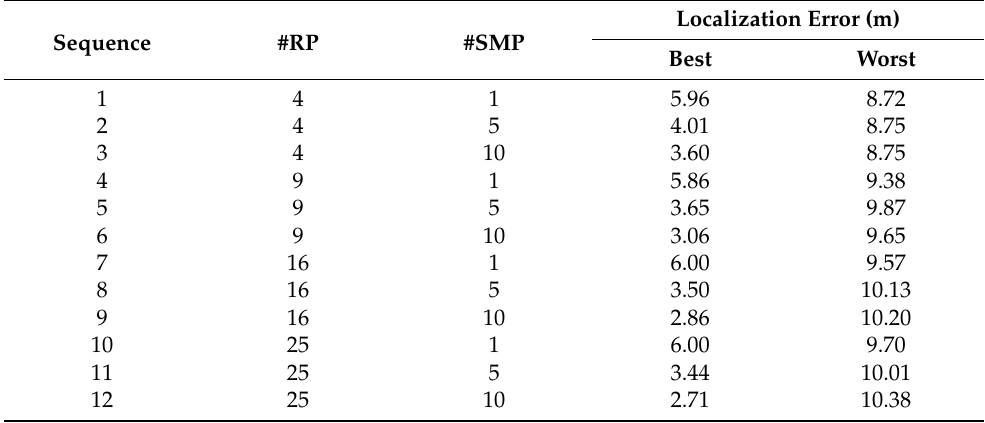
Table 2. Ninety-five percent of cumulative error results obtained for different configurations of 3